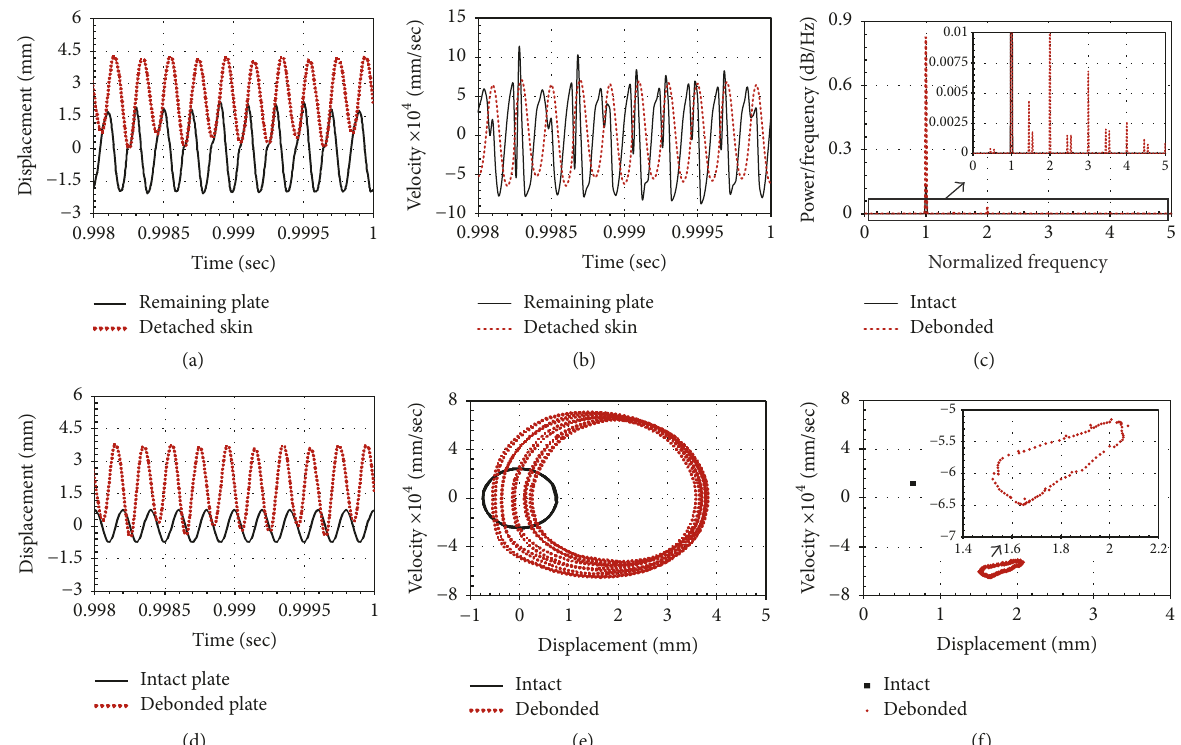
Figure 27: Steady-state dynamic response at 𝜂 = 5(Ω = 5000 Hz ) : ((a)-(b)) displacement and velocity time histories at points N2 and N3; (c) frequency spectra of the displacement signals at point N1; (d) displacement time histories at point N1; (e) phase portrait at point N1 [80]; and (f) Poincar´e section at point N1.